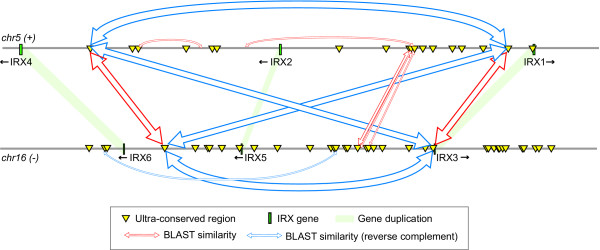
Sets of UCRs sharing high sequence similarity are involved in regulation of related genes: the case of Iroquois gene clusters. Four similarly positioned UCRs are located within the two Iroquois gene clusters at chromosomes 5 and 16. Block arrows indicate significant sequence similarity. The arrow width is inversely proportional to the alignment BLASTN E-value. There are additional shorter blocks of similarity between the two three-gene clusters; however, most UCRs have diverged between the two clusters, while still preserved across vertebrates.